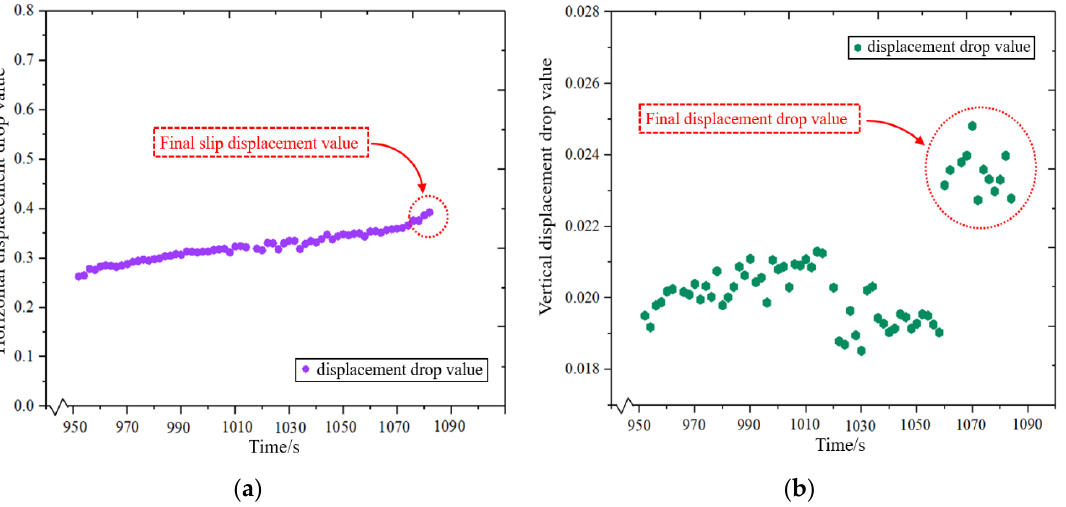
Figure 15. Final displacement drops value. ( a ) Final vertical drops in the horizontal direction in 950 s~1088 s ( b ). Final vertical drops in the horizontal direction in 950 s~1088 s. Finally, the displacement drop value of the granite sample was calculated and compared. The relationship between the horizontal and vertical displacements dropped and different angles were obtained and are shown in Figure 16. As shown in Figure 16a, with increasing fracture dip angle, the displacement drops increased as well. The horizontal displacement drop value of the unbonded fracture (sample O) was 0.221 mm, while the horizontal displacement drop values of the 0 ◦ , 15 ◦ , 30 ◦ , and 45 ◦ bonded fractures were 0.393 mm, 0.554 mm, 1.282 mm, and 1.344 mm, respectively. According to Figure 16b, the vertical displacement drop value of the unbonded fracture was 0.051 mm, while